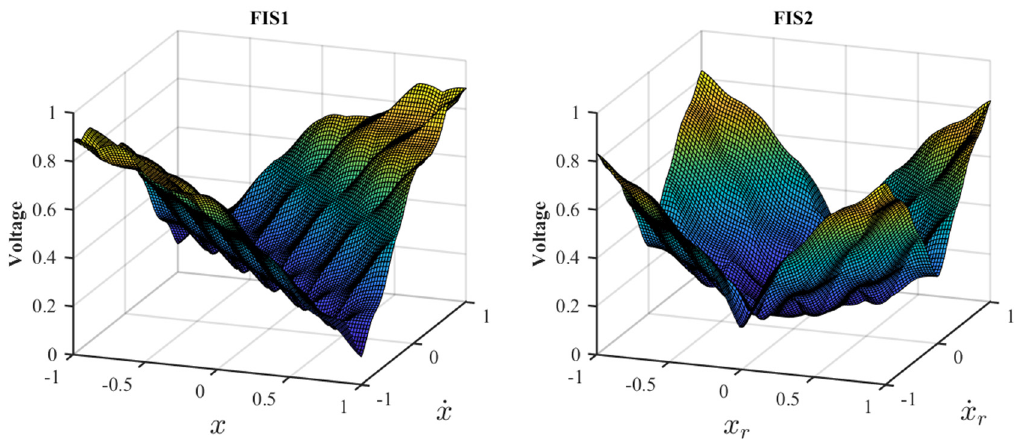
Figure 6. The surface plot of the FIS1 and FIS2, which are used in the SPC algorithm.